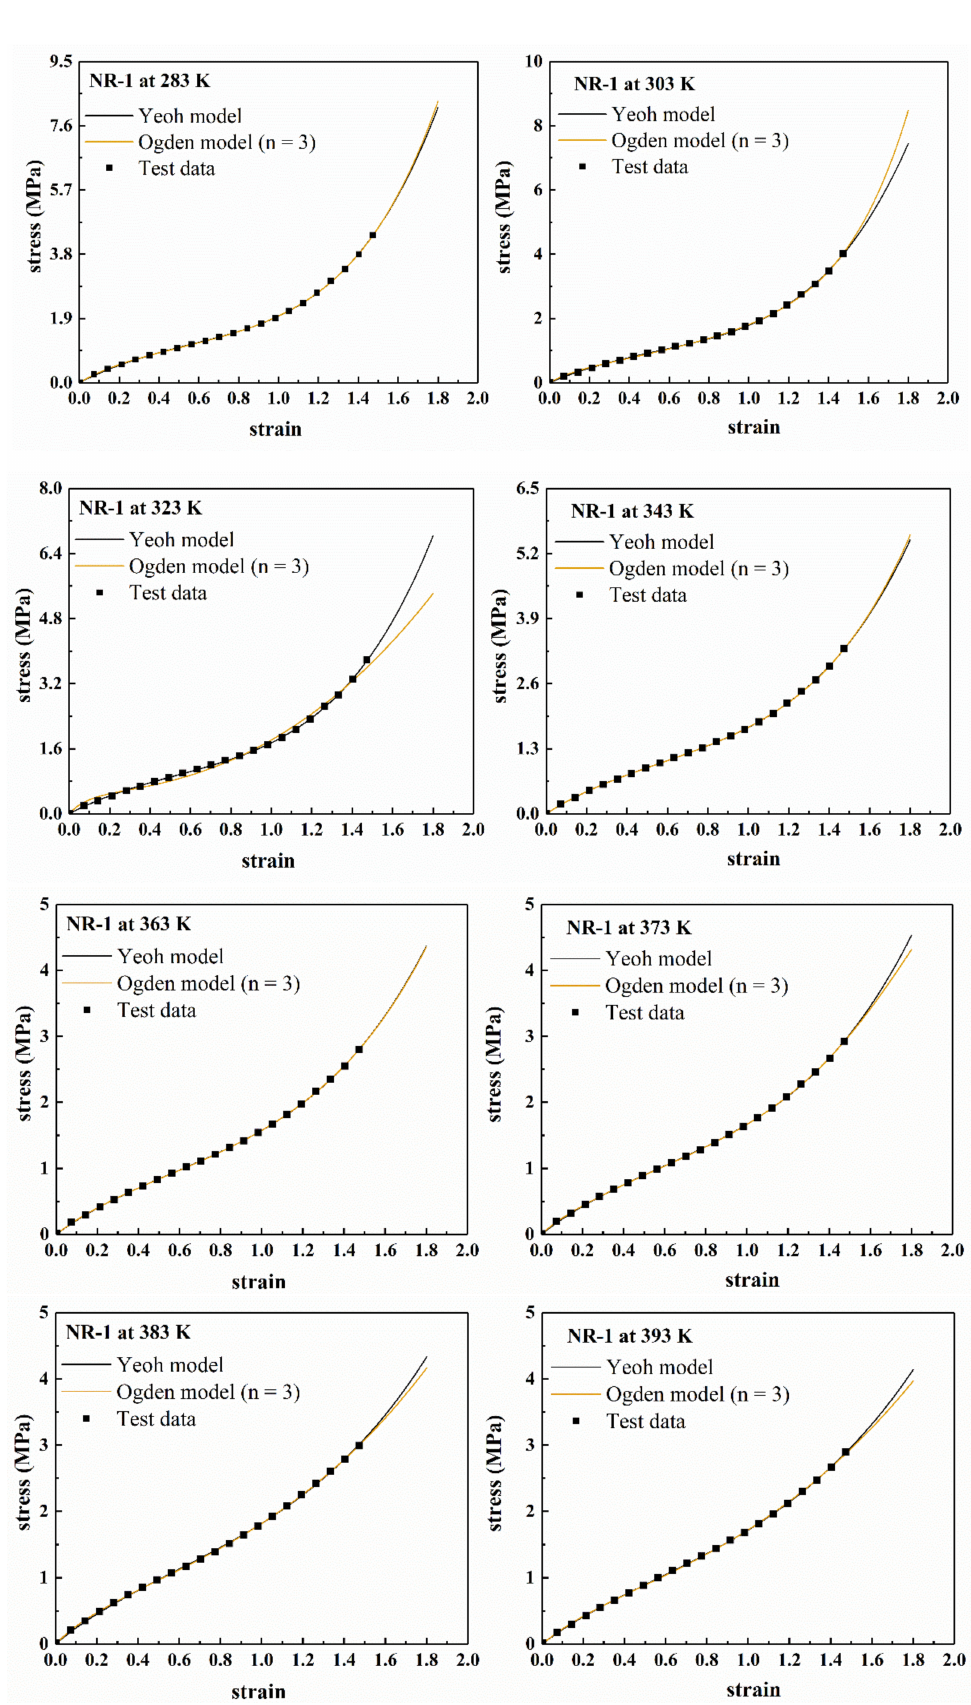
Figure 8. The fitting results of the Yeoh model and the Ogden model ( n = 3) for NR-1 under uniaxial tension at different